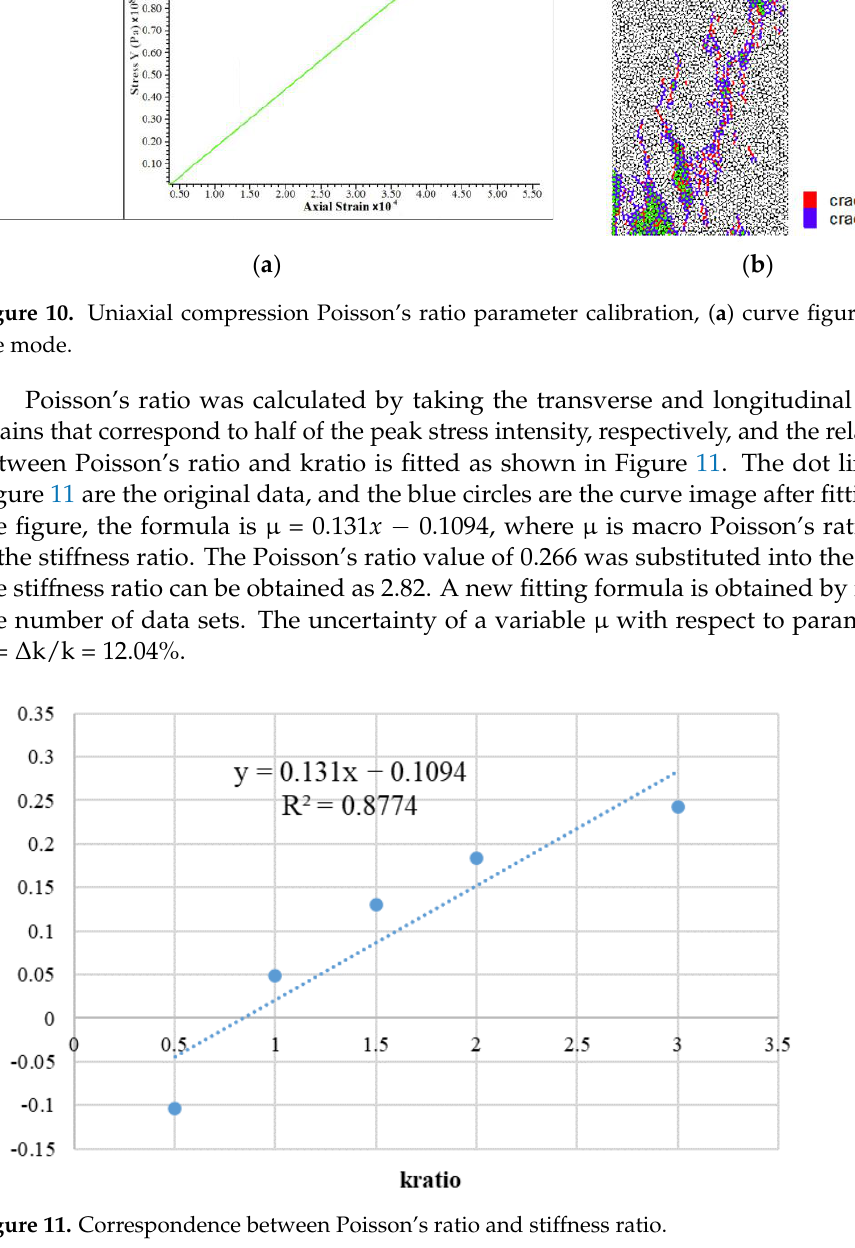
Figure 11. Correspondence between Poisson ’ s ratio and stiffness ratio. For the bonding ratio, after determining the effective contact modulus and stiffness ratio of linear bond and parallel bond, the normal bond or tangential bond strength is defined as the bonding ratio (ten_coh). To study the failure modes of specimens under different bond combinations, the bonding ratio was defined as 0.1, 0.5, 1.0, 1.2, 1.5, and 2.0, and the damage results of the specimens are shown in Figure 12, where green means shear crack and red means tension crack.